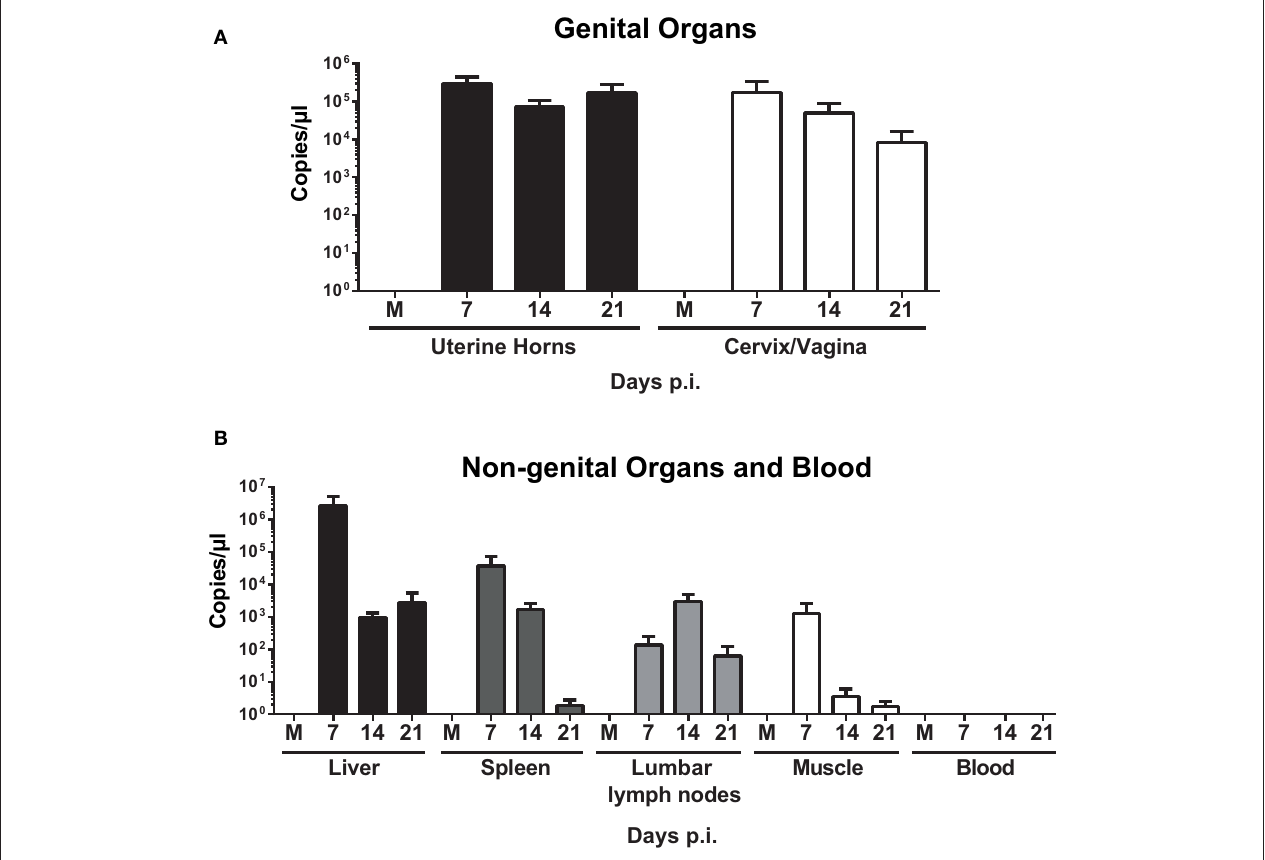
FIGURE 2 | Quantification of W. chondrophila in genital and non-genital organs. Mice were infected with live 10 9 W. chondrophila or mock (M). (A) Bacterial burden in uterine horns and cervix/vagina at days 7, 14, and 21 p.i. (B) Bacterial burden in liver, spleen, lumbar lymph nodes, muscle, and blood at days 7, 14, and 21 p.i. qPCR values represent the mean SEM. Results are representative of two independent experiments with n = 3 and 5 for each experiment.